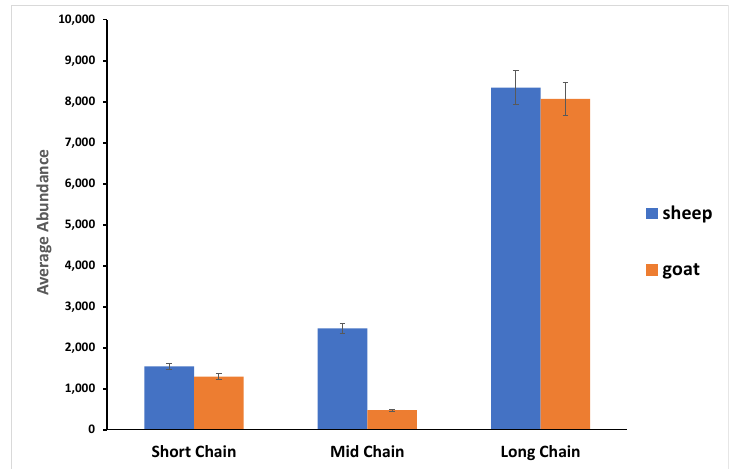
Figure 2. Average abundance values of the short, medium and long fatty acids at the sn ‐ 2 position.